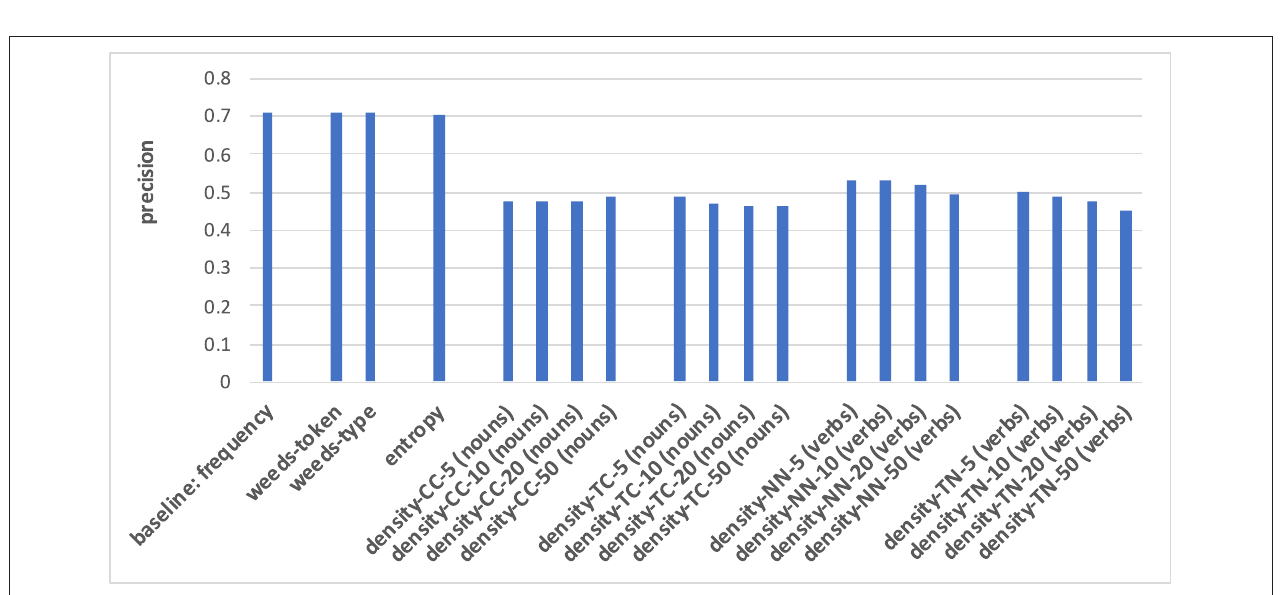
FIGURE 7 | Pair-wise precision results for hypernymy of nouns relying on an N-V-A vector space. Densities take only nouns as context/neighbour words into account.